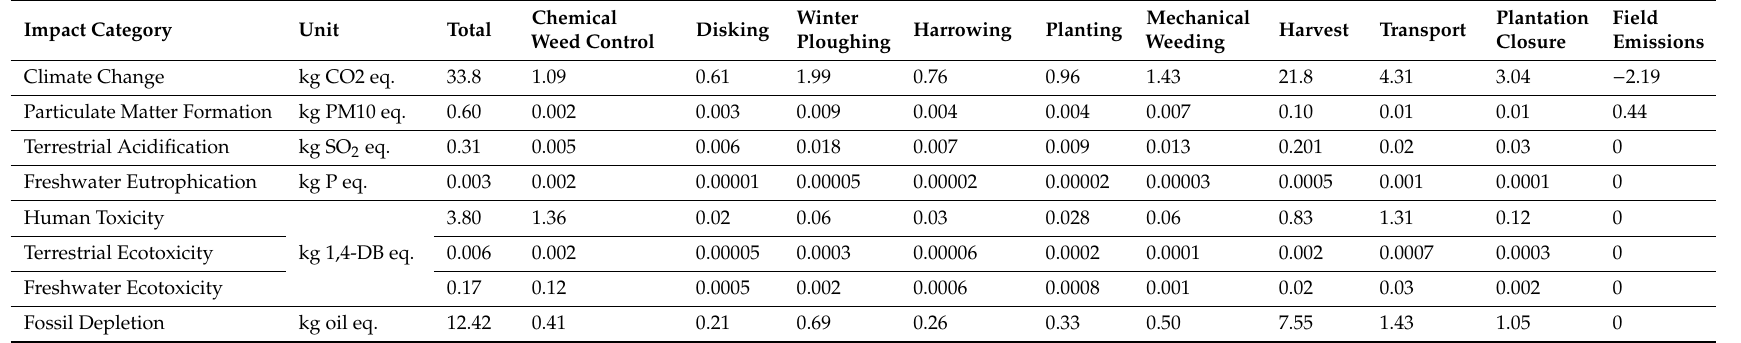
Table 3. Environmental impact of miscanthus production without fertilisation (base scenario) per 1 Mg of biomass dry